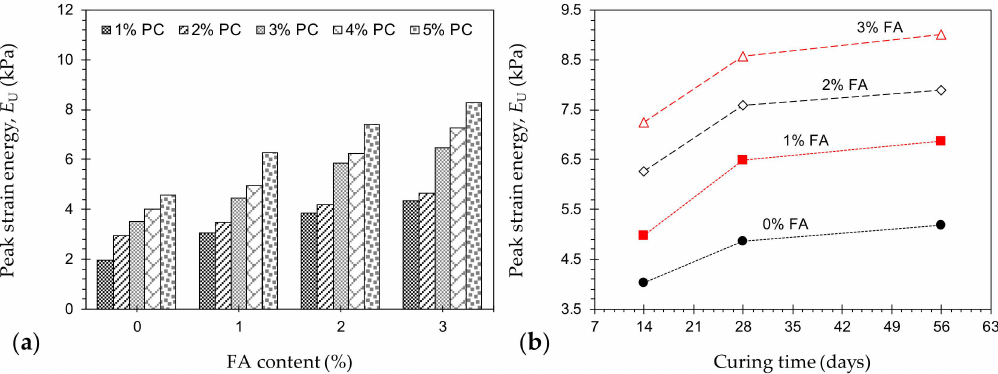
Figure 4. ( a ) Variations of E U against FA content for various mix designs tested at 14 days of curing— P a F b T 14 where a = {1, 2, 3, 4, 5}, and b = {0, 1, 2, 3}; and ( b ) Variations of E U against curing